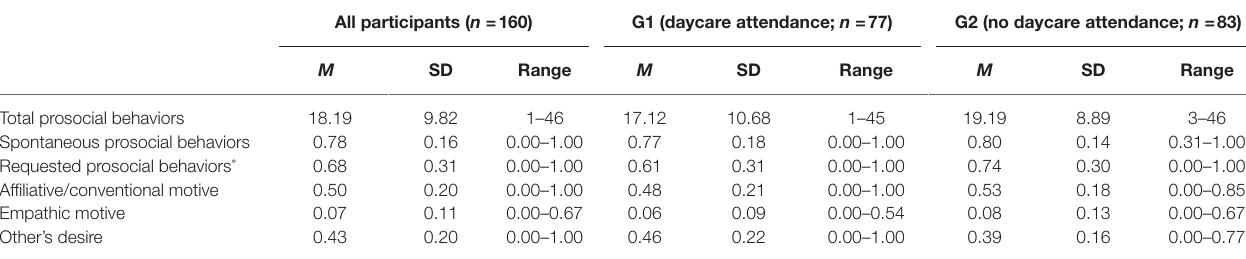
TABLE 1 | Descriptive data for prosocial behavior